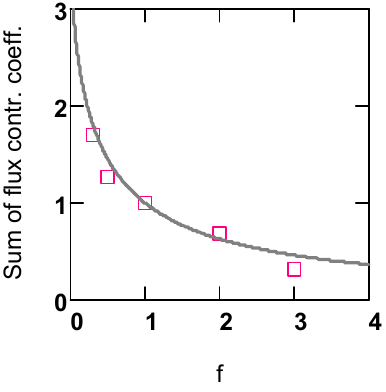
C  versus perturbation f . (red squares) Figure 3. Sum of flux control coefficients J Enz results from simulation SIM with variable conductances; (grey line) analytical curve GLY   J C f  for constant Enz